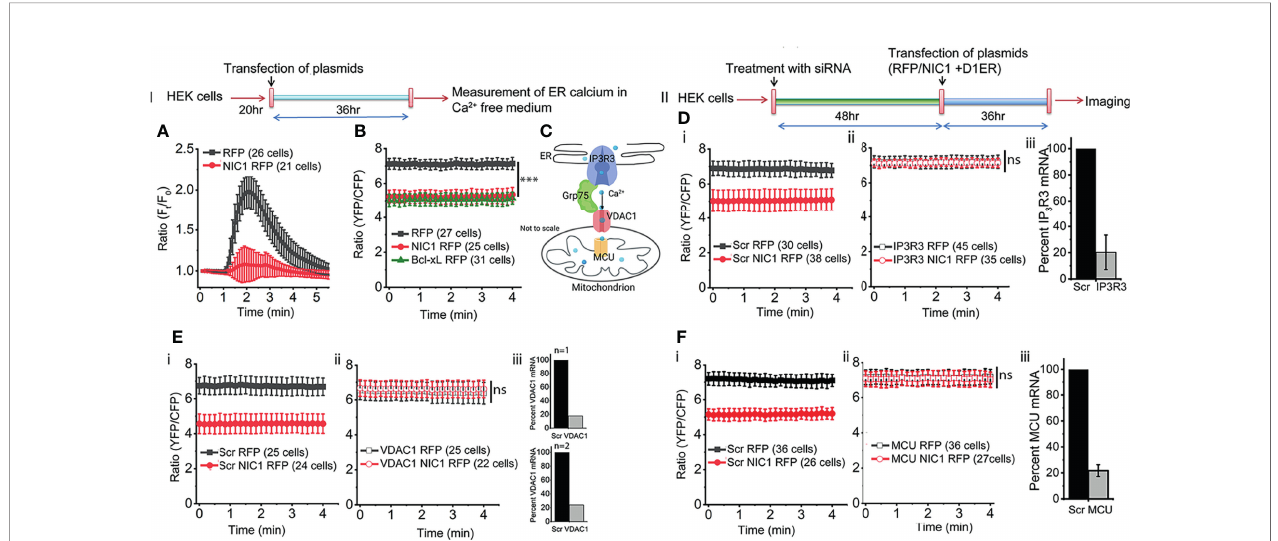
FIGURE 2 | NIC1 signaling regulates ER calcium levels. Schematic (I) Timeline of experiments assessing changes in ER calcium levels. Schematic (II) Timeline of experiments, in cells treated with siRNA before assessing changes in ER calcium levels. (A) Fluo4 fl uorescence in HEK cells expressing NIC1-RFP ( (cid:129) ) or RFP ( ▪ ), at time-t (F t ) relative to onset (F 0 ) measured in calcium free medium at baseline and in response to 2 m M TG. (B) YFP/CFP ratio in HEK cells co-transfected with D1ER and NIC1-RFP ( (cid:129) ) or, Bcl-xL-RFP ( ▴ ) or, RFP ( ▪ ) and cultured for 36 h before imaging. (C) Schematic (not to scale) depicting - IP3R3, Grp75, VDAC1 and MCU- in the context of ER and mitochondria. (D – F) Ratio of YFP/CFP fl uorescence in HEK cells, imaged 36 h after co-transfection with D1ER and NIC1-RFP ( ⚬ ) or RFP ( ▫ ), in cells pre-treated with siRNA to IP3R3 (D-ii) or VDAC1 (E-ii) or MCU (F-ii) or scrambled control ( D-F-i , NIC1-RFP ( (cid:129) ) and RFP ( ▪ ). (D – F iii) Percent mRNA levels of the genes as shown in panels, in cells treated with siRNA to IP3R3 ( D , N=3) or VDAC1 ( E , N=2) or MCU ( F , N=3) and scrambled control. Data plotted as mean ± SD of the indicated number of cells in 6-12 fi elds across three (A, D, F) or two (B, D) independent experiments. *** indicates signi fi cant difference at all time points with p-values ≤ 0.001 and ns: not signi fi cant, examined using unpaired student ’ s